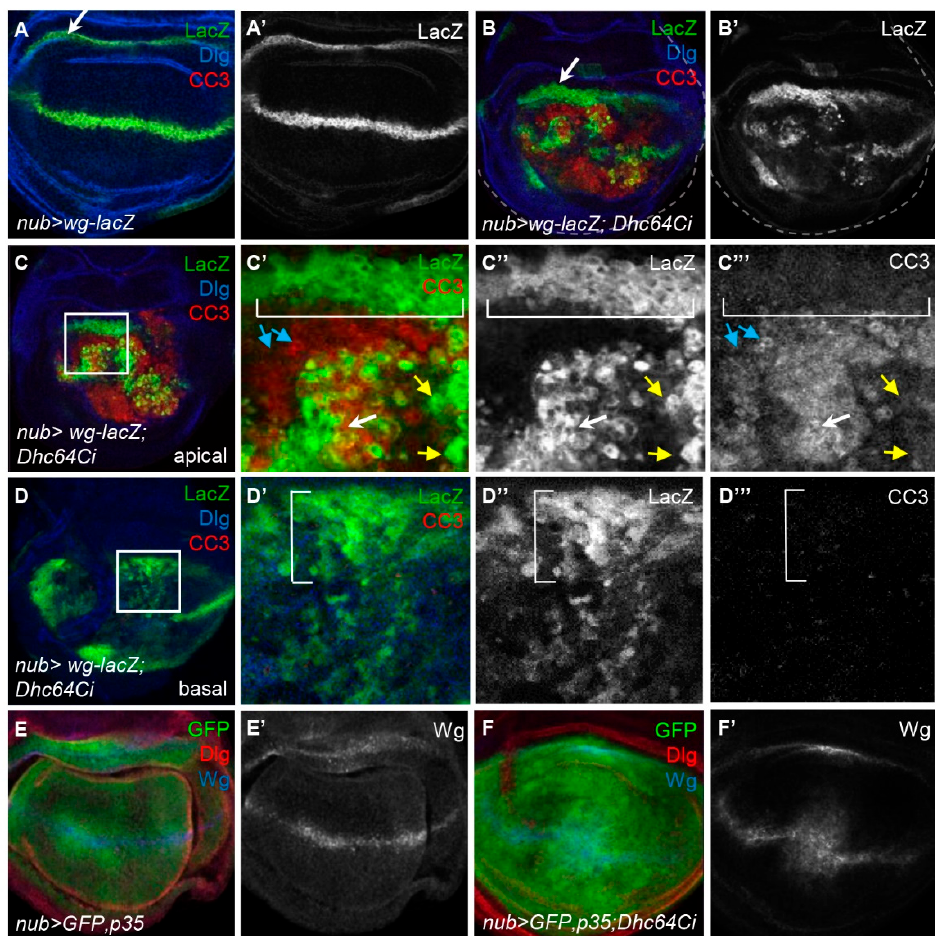
Figure 5. Knockdown of Dhc64C induces cell death and cell proliferation of Wg-producing cells in the apical and basal region of wing discs, respectively. ( A-A’, B-B’ ) Comparison of Wg-lacZ pattern between a nub-Gal4 > wg-lacZ control disc ( A, A’ ) and a nub-Gal4 > wg-lacZ; Dhc64Ci wing disc ( B, B’ ) at the basolateral region. ( B ) is one of Z-stack images of a nub-Gal4 > wg-lacZ; Dhc64Ci wing disc in Figure S4. ( C, D ) Apoptotic cells are present in the apical region but not in the basal region. Images representing apical ( C ) and basal ( D ) region of a nub-Gal4 > wg-lacZ; Dhc64Ci wing disc are selected from the same Z-stack images in Figure S4. The boxed regions in C and D are magnified in C’–C’’’ and D’–D’’’. Apically located Wg-lacZ cells in the hinge region (brackets) show no apoptosis ( C ). Some Wg-lacZ cells (white arrows) are apoptotic while others (yellow arrows) are not in the pouch ( C ). Most pouch cells that do not express Wg-lacZ (blue arrows) are apoptotic ( C ). Basally located Wg-lacZ cells in the hinge region are increased in their number, and were dispersed into the pouch region (brackets in D’–D’’’). ( E-E’, F-F’ ) Abnormal Wg pattern induced by the knockdown of Dhc64C is rescued by p35. Compared to Wg pattern of nub > GFP , p35 wing discs ( E ), that of nub > GFP; p35, Dhc64Ci wing ( F ) are almost normal unlike Figure 4B.